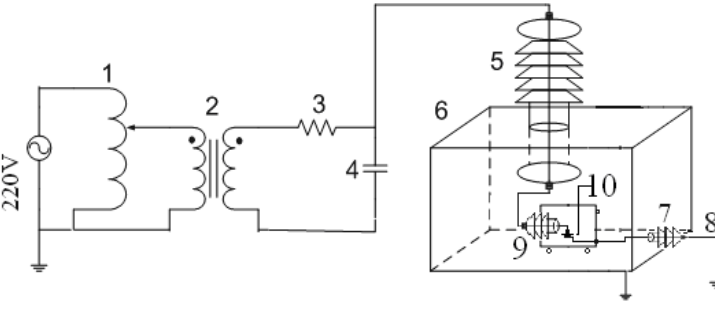
Figure 1. Schematic diagram of the aging experiment in the laboratory. (1) regulator;